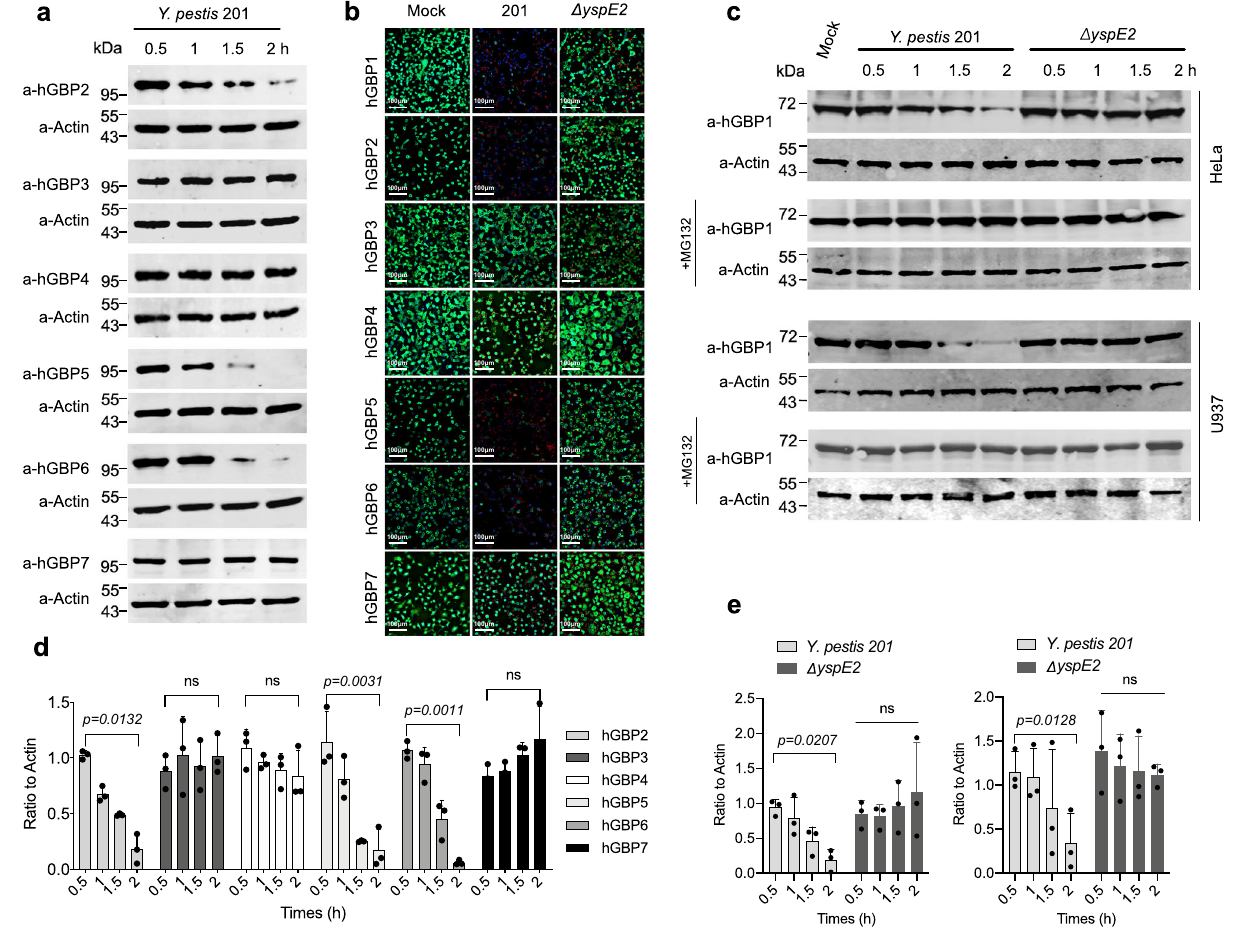
Fig. 3 | Y. pestis degrades multiple hGBPs during infection. a HeLa cells stably expressing GFP-hGBP1-7 were infected with Y. pestis 201 and hGBPs in samples collected at different times were immunoblotted with speci fi c antibodies. b HeLa cells stably expressing GFP-hGBP1-7 were infected with Y. pestis or Δ yspE2 , and confocal fl orescence images were taken at 2.5 hpi. The images represent results fromthreeindependentexperiments. c EndogenousGBP1degradationinHeLaand